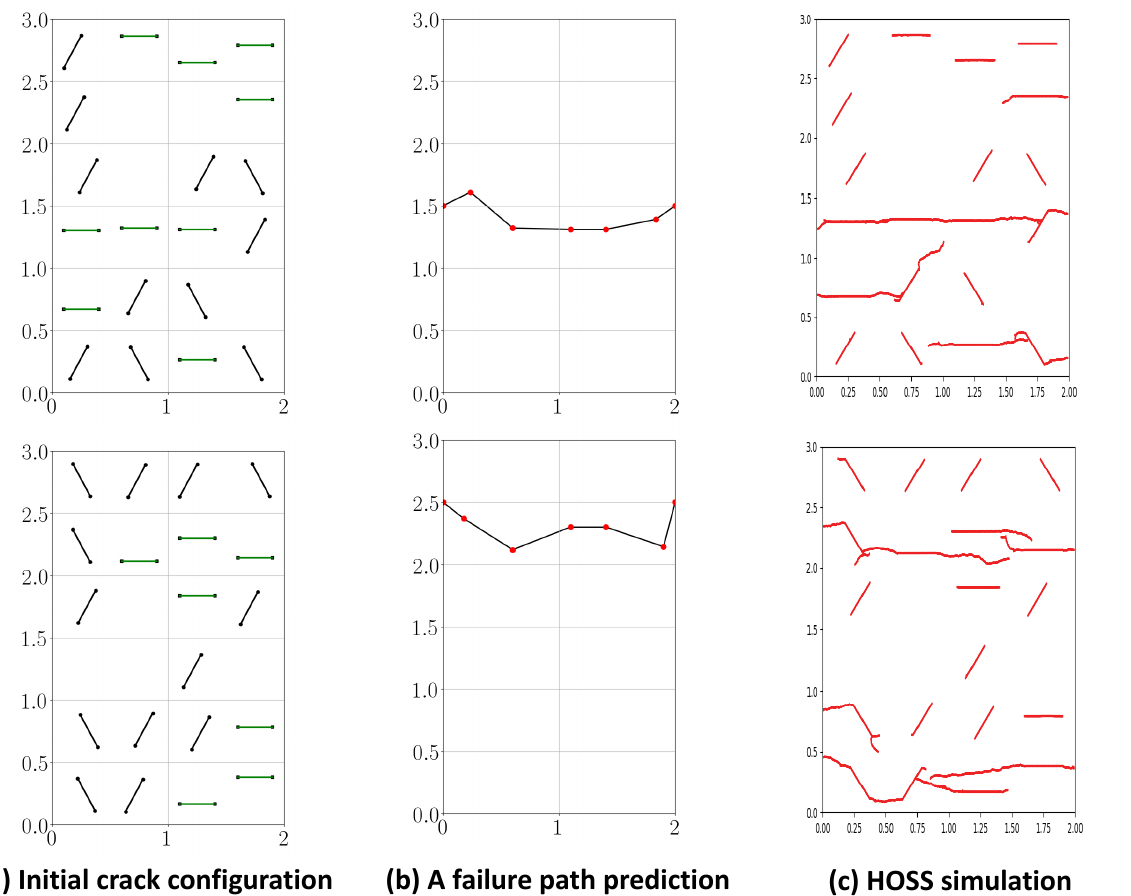
Figure 7. Failure path prediction (one failure path, greater than 50% match): The above set of figures show results where the initial cracks in the predicted failure path have a greater than 50% match with those in the HOSS predicted failure